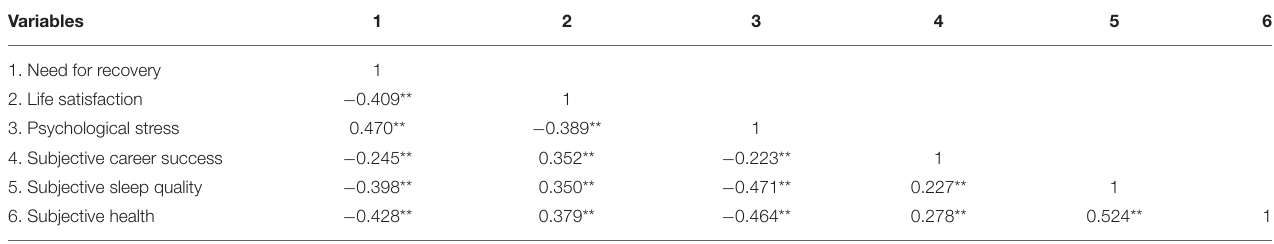
TABLE 3 | Means, standard deviations (SD), and correlations of continuous variables.